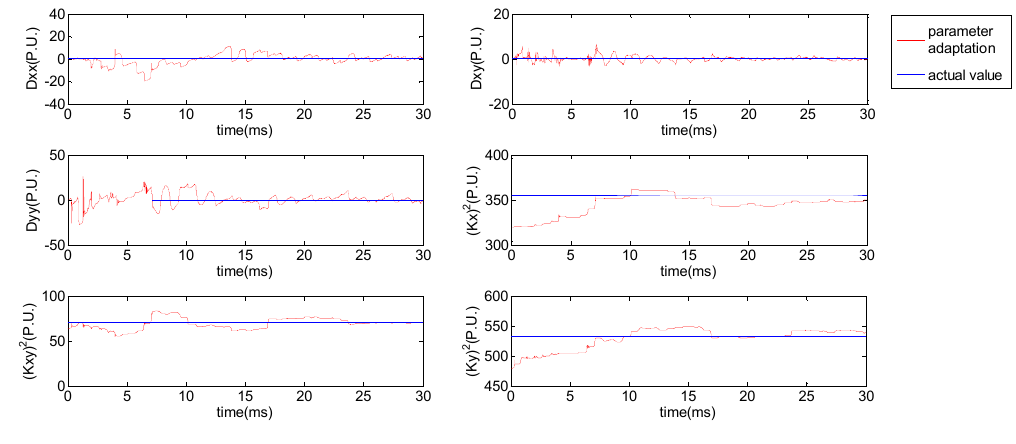
Figure 15. Adaptation performance of system parameters.